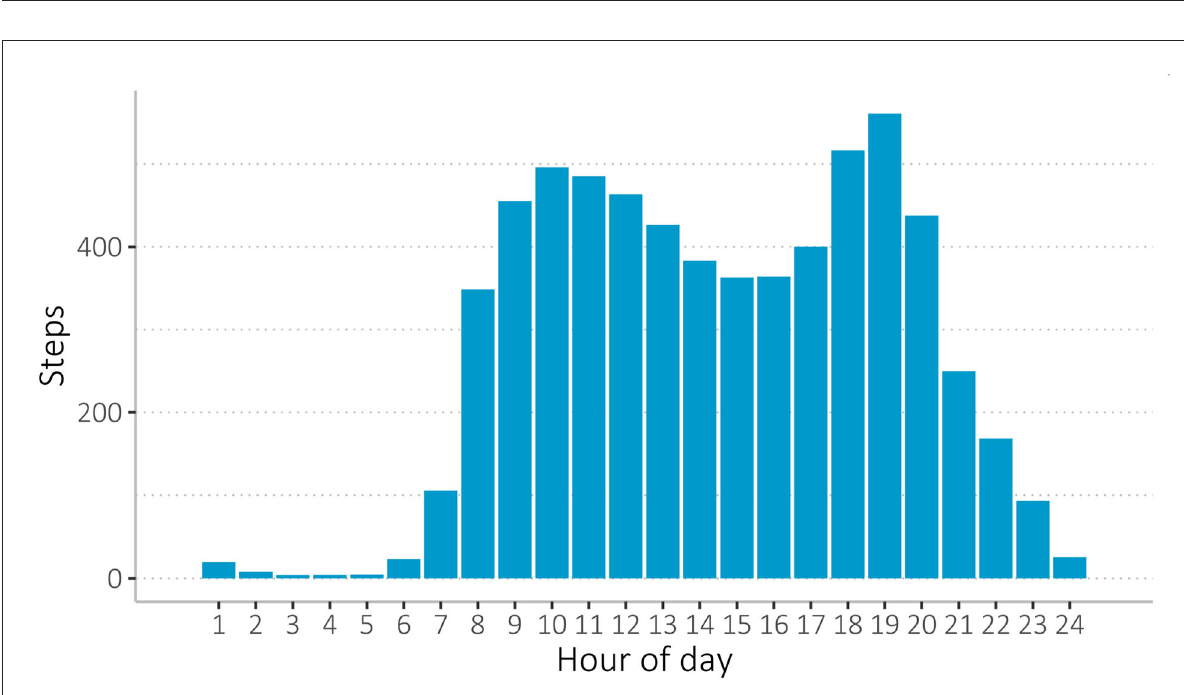
$6, which reflects a typical participation rate in the Nouna HDSS, may have been considerable for some and boosted